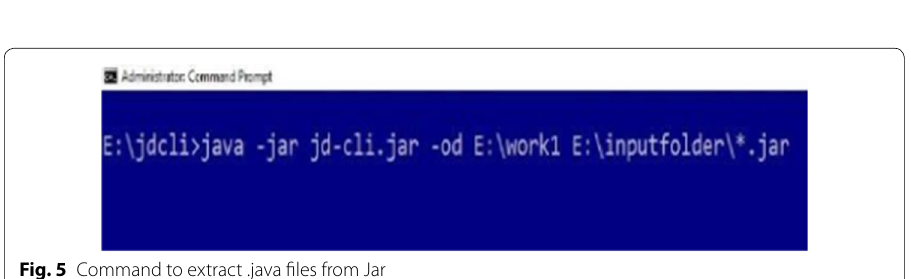
Fig. 5 Command to extract .java files from Jar